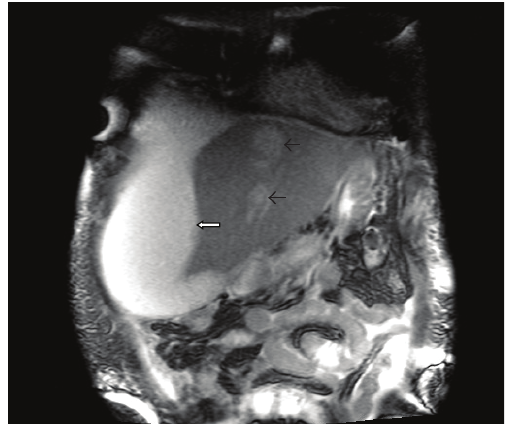
Figure 3: MRI of the abdomen with a large subcapsular abscess and coalescence of hepatic lesions into larger